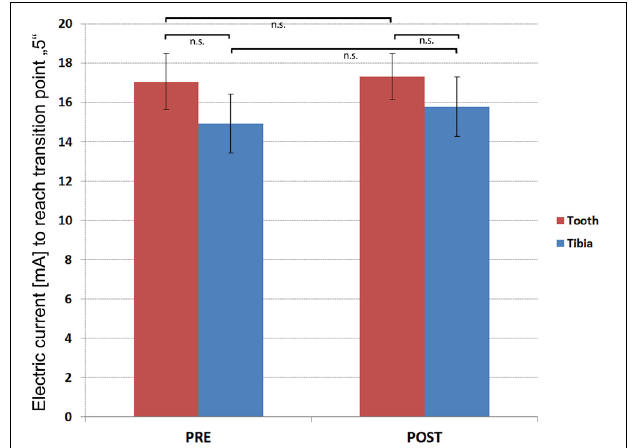
FIGURE 4 | Results of the pain matching. Y-axis illustrates the group ( N = 15) mean electric current (mA) that was needed to reach the transition point. T-bars indicate standard errors of the mean ( ±